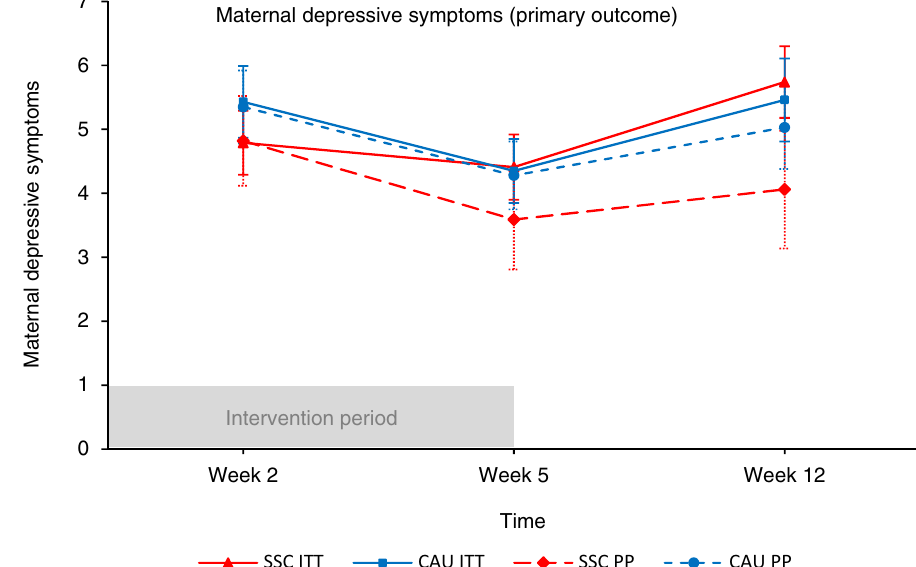
Figure 2. Maternal postnatal depressive symptoms during the first twelve postnatal weeks in the skin-to-skin contact (SSC) and care-as-usual (CAU) condition for the intention-to-treat (ITT) selection and per-protocol (PP) selection. Winsorized data is presented for all variables that included outliers. Error bars represent standard errors of the mean. Analyses showed that the trajectory of maternal depressive symptoms over the first twelve postnatal weeks was not different between SSC mothers and CAU